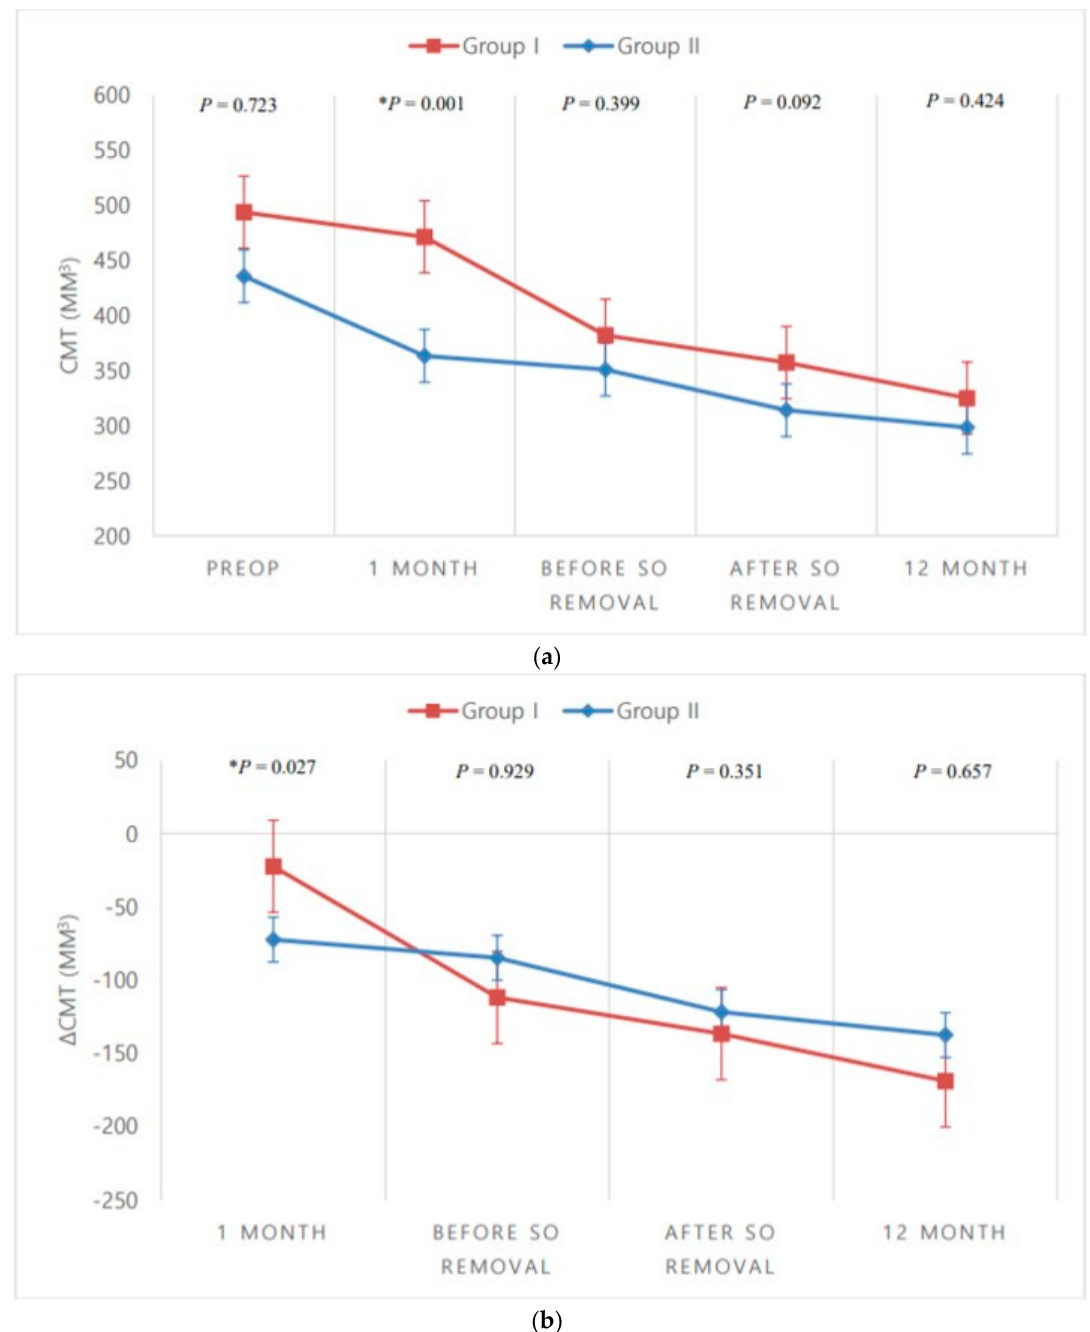
Figure 2. Between-group comparisons over time. ( a ) Mean central macular thickness (CMT); ( b ) Mean change in CMT from the preoperative (Preop) status. * p < 0.05, Mann–Whitney U -test. SO, silicone oil.